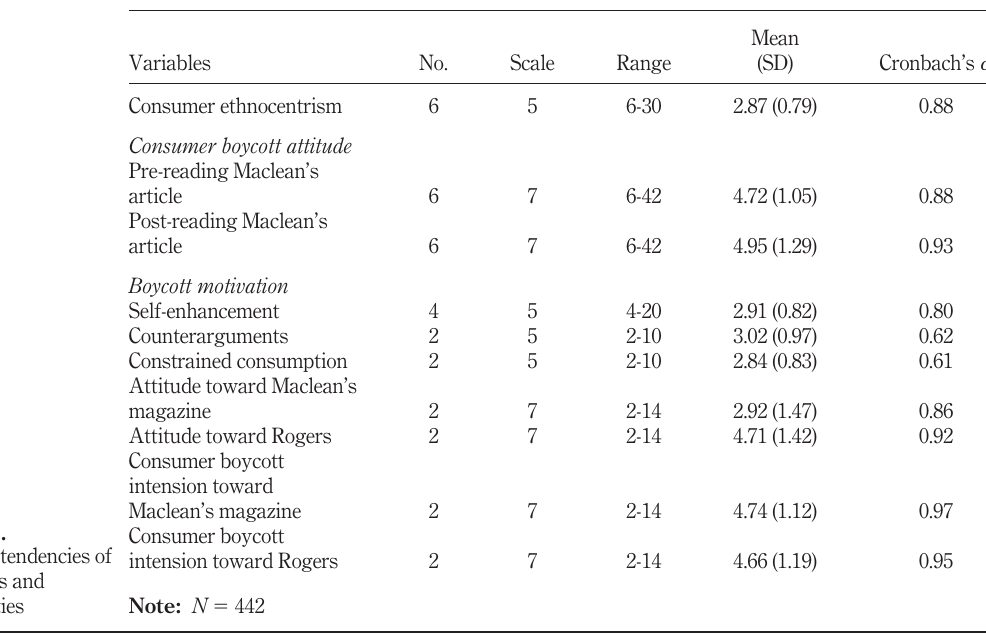
Table I. General tendencies